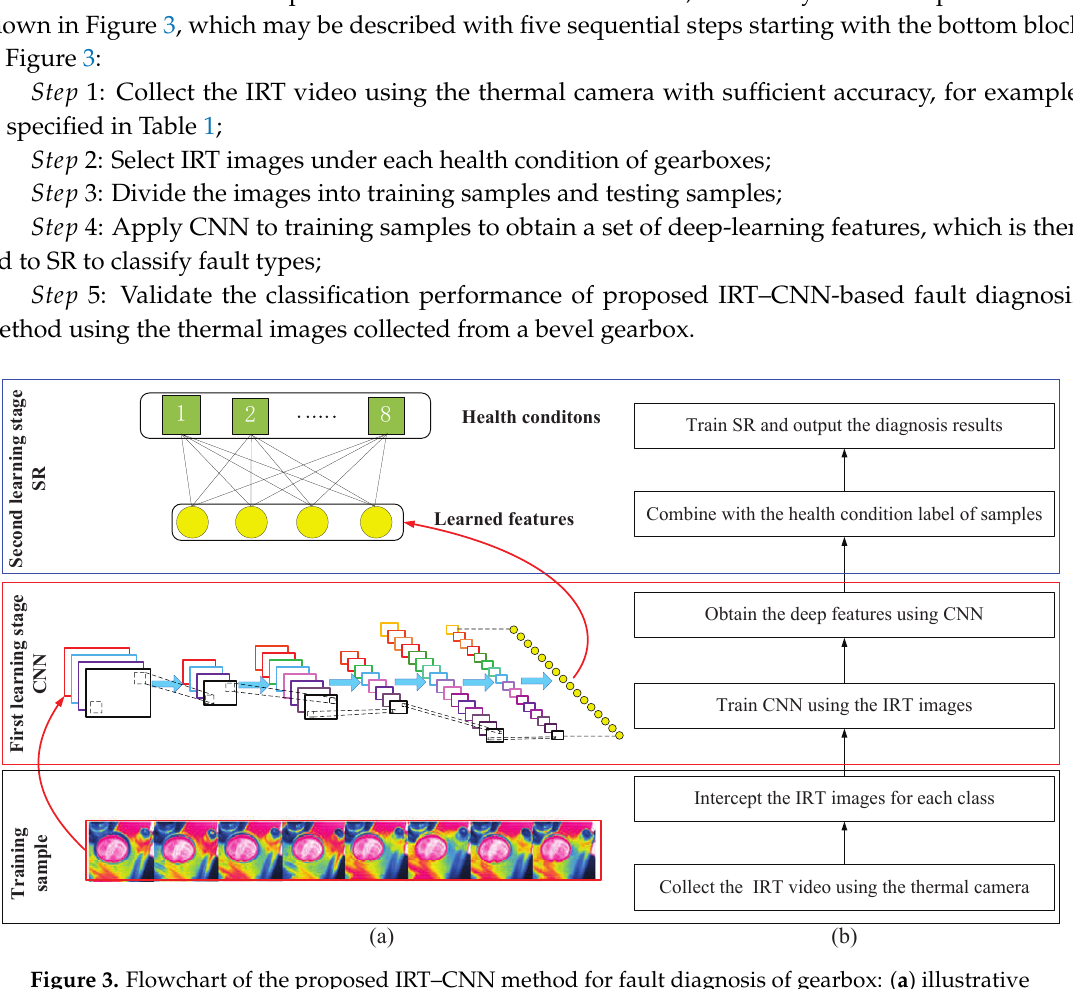
Figure 3. Flowchart of the proposed IRT–CNN method for fault diagnosis of gearbox: ( a ) illustrative diagrams, and ( b ) flowchart of training